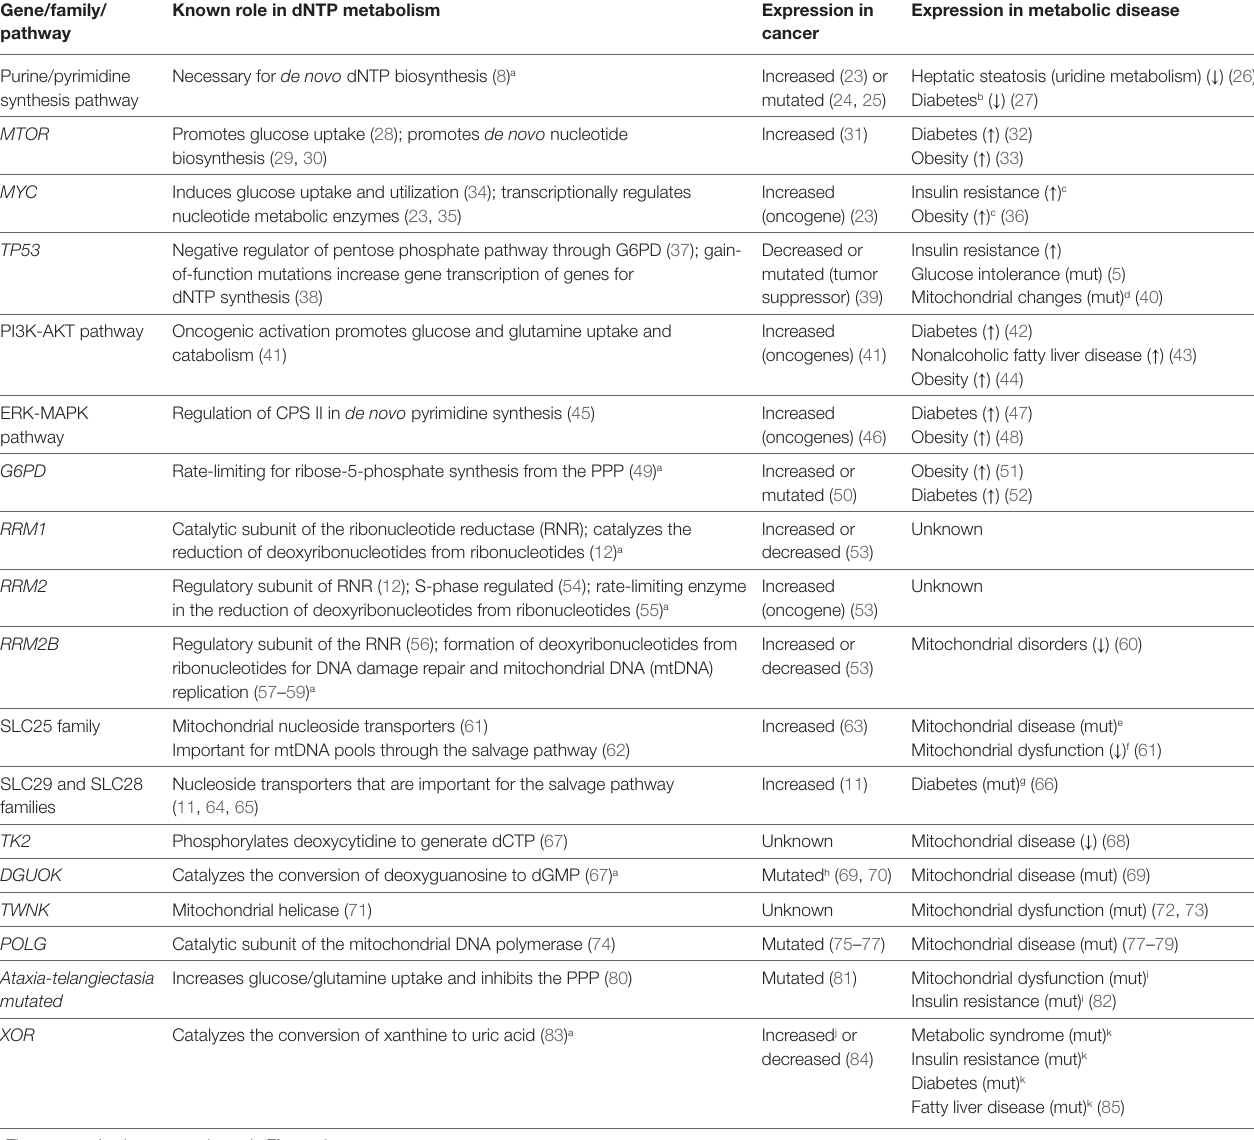
TABLe 1 | Genes, protein families, and pathways discussed in this review: role in deoxyribonucleotide triphosphate (dNTP) metabolism and expression in cancer and metabolic disease. Gene/family/